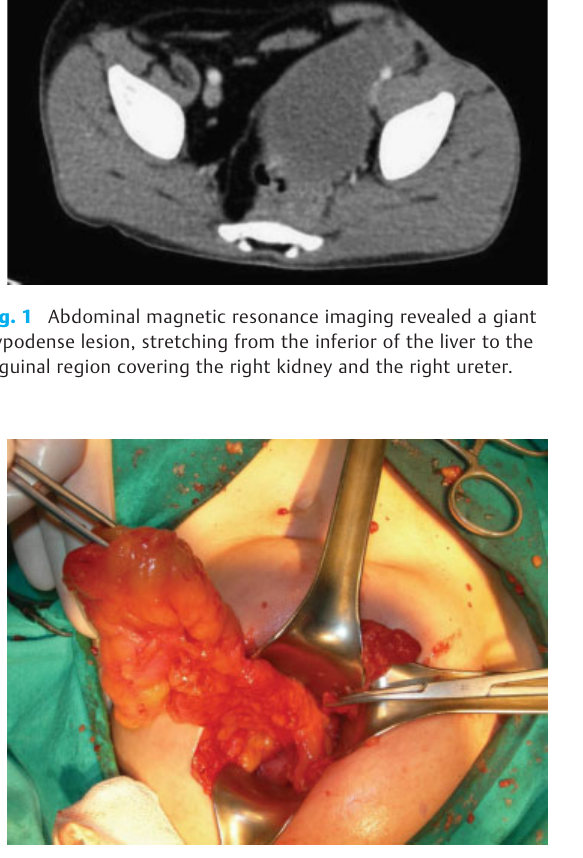
Fig. 2 Abdominal lipomatosis was meticulously dissected from the surrounding organs and completely excised.